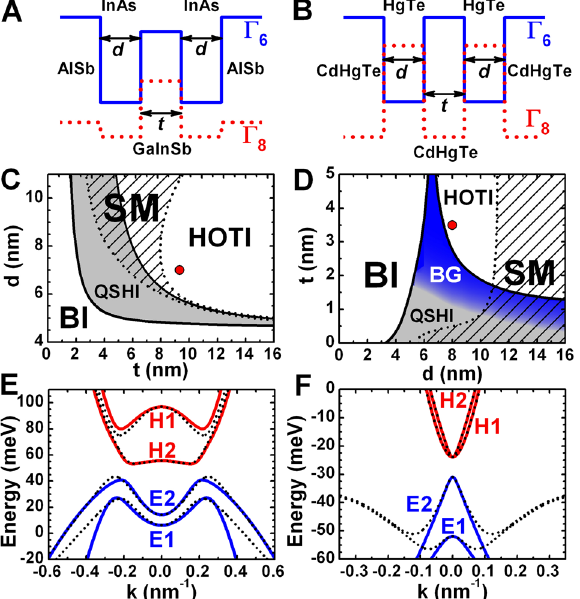
Figure 1. Band structure of three-layer InAs/GaInSb and double HgTe/CdHgTe QWs. ( A ) Schematic representation of symmetrical three-layer InAs/Ga 0.65 In 0.35 Sb QW confined by outer AlSb barriers 50 . Here, d and t are the thicknesses of InAs and Ga 0.65 In 0.35 Sb layers, respectively. The QW is supposed to be grown on (001) GaSb buffer. ( B ) Schematic representation of double HgTe/Cd 0.7 Hg 0.3 Te QW. Here, d is the thickness of HgTe layers and t is the middle CdHgTe barrier thickness. The double QW is assumed to be grown on (001) CdTe buffer. The Hg content in all the barriers is chosen to be 0.3 51 . ( C , D ) The phase diagrams for different d and t . The left-hand and right-hand solid curves correspond to the crossing between E 1– H 1 subbands and E 2– H 2 subbands, respectively. These curves divide the plane into three parts with trivial band ordering corresponding to band insulator (BI, see the left-hand white region), single band inversion (grey and blue regions) and double-band inversion (right-hand white region). The striped region defines a semimetal (SM) phase with vanishing indirect band-gap 50,51 . ( E , F ) Band structure calculated on the basis of effective 2D low- energy Hamiltonian for the QWs with the layer thicknesses marked by the red symbols in ( B ) and ( C ). The blue and red curves represent band dispersion of electron-like and hole-like subbands, respectively. The wave vector is oriented along (100) crystallographic direction. The dotted curves represent the calculations based on realistic multi-band k p Hamiltonian 49 ·